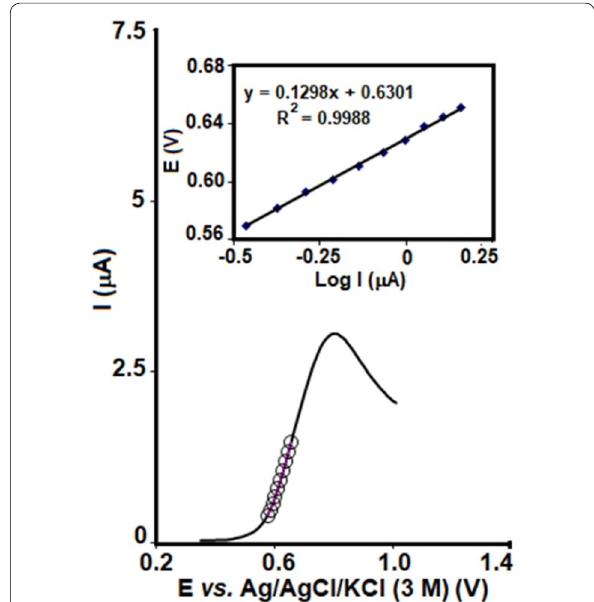
Fig. 3 Tafel plot derived from LSV of MCSNP/SPE in 0.1 M PBS (pH 7.0) containing 20.0 µM ACh at scan rate of 5 mV/s